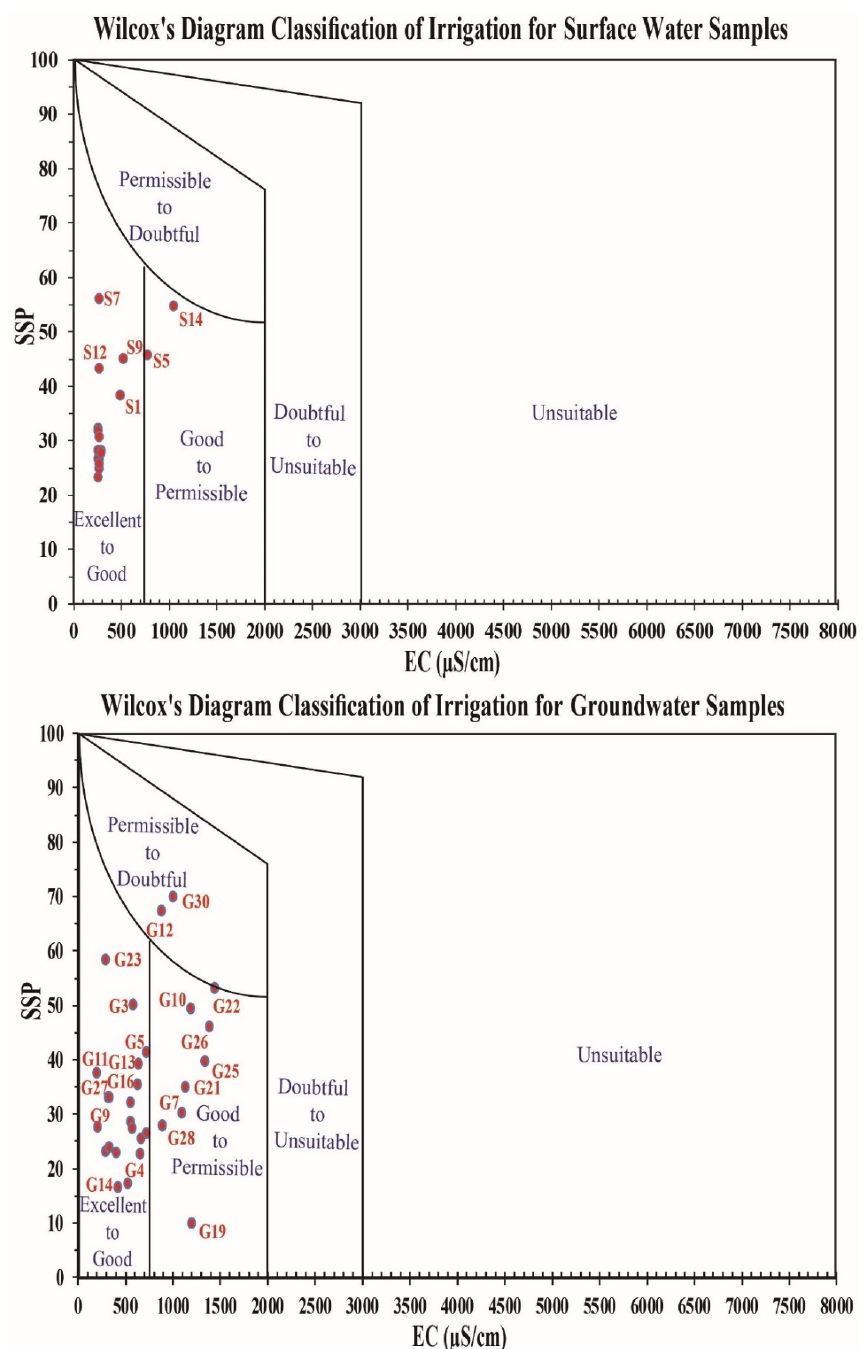
Figure 7. Classi fi cation of water irrigation based on the Wilcox diagram. Figure 7. Classification of water irrigation based on the Wilcox